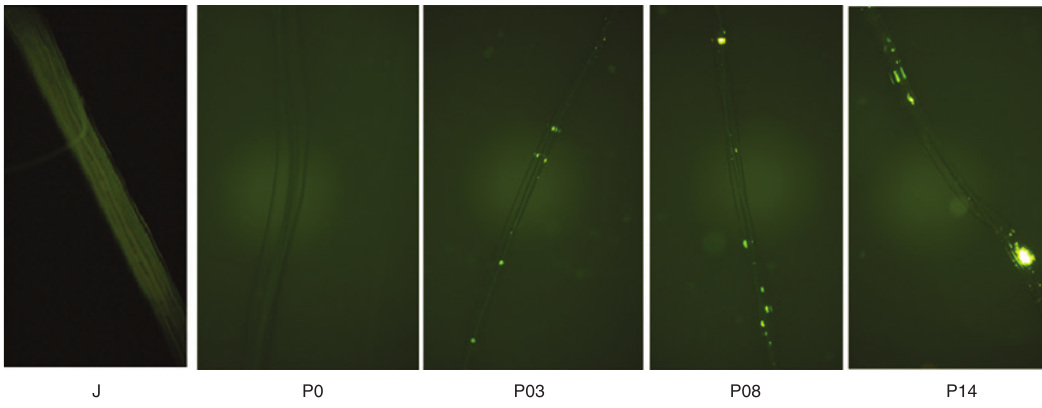
Figure 9: Fluorescence micrographs of the jute fiber ( × 20) and the polypropylene filaments ( ×